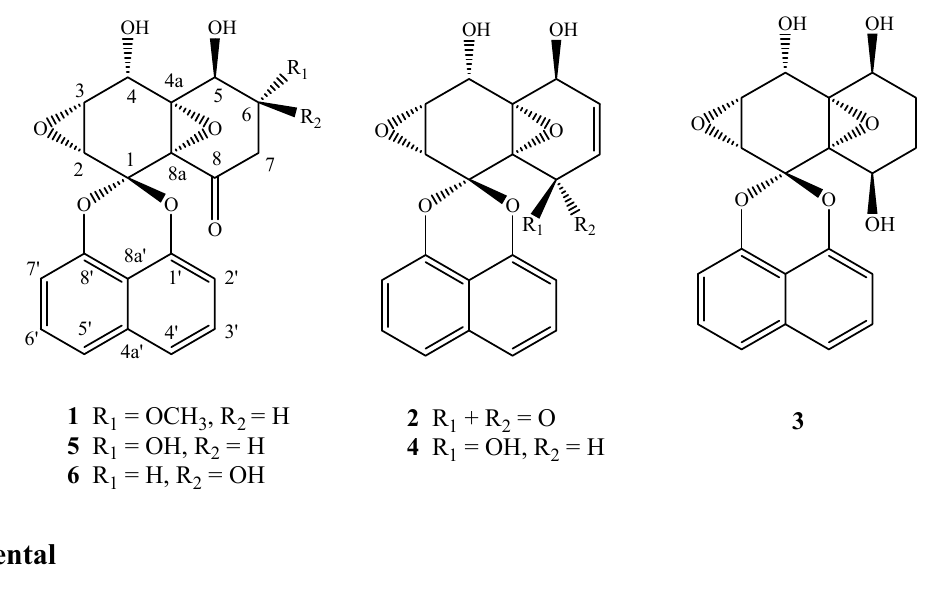
Figure 4. The structures of compounds 1 – 6